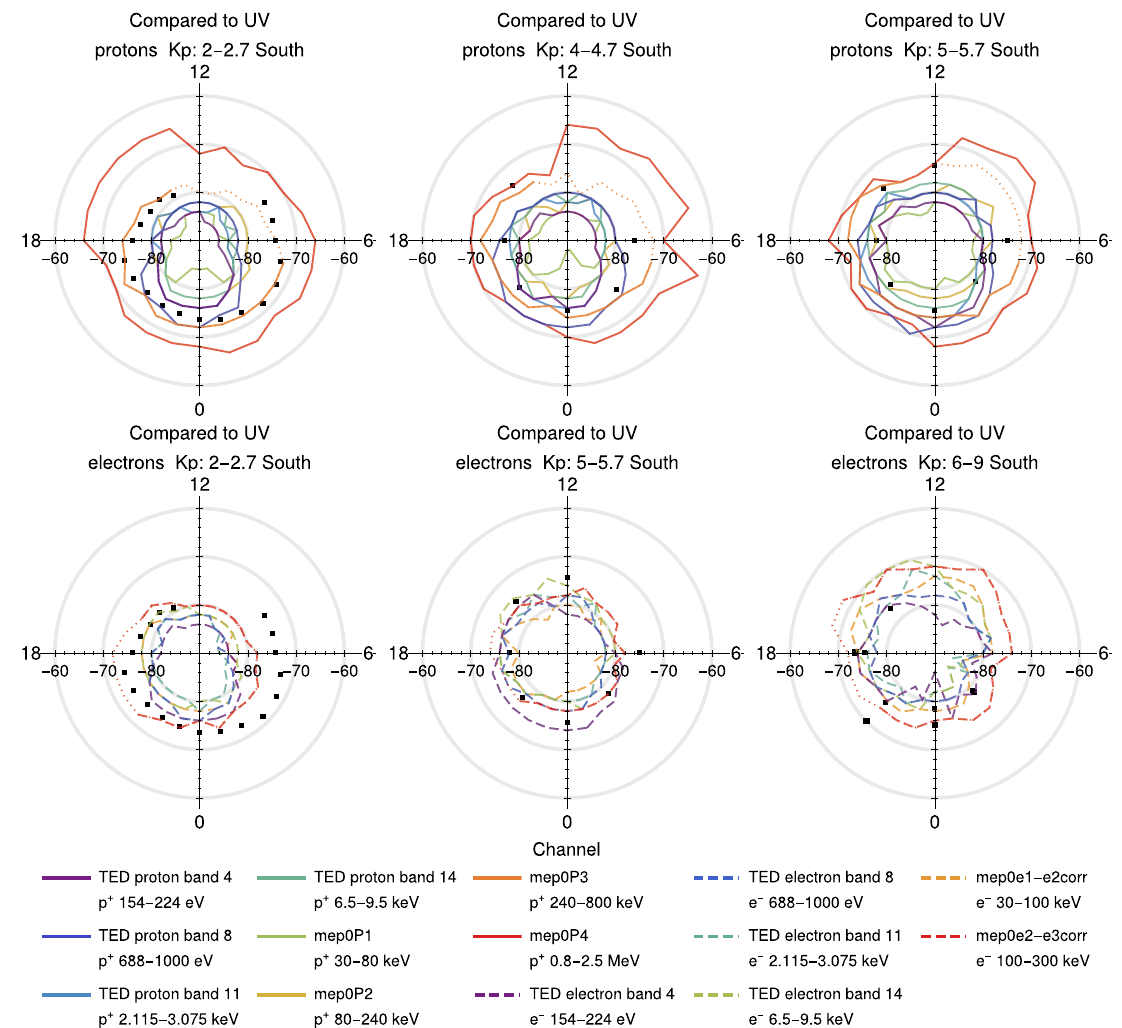
Figure 8. Comparison of the PPFD areas from all channels at selected Kp levels with the corresponding poleward boundary of the auroral UV measurements (black squares) from Figures 4 and 6 in Carbary